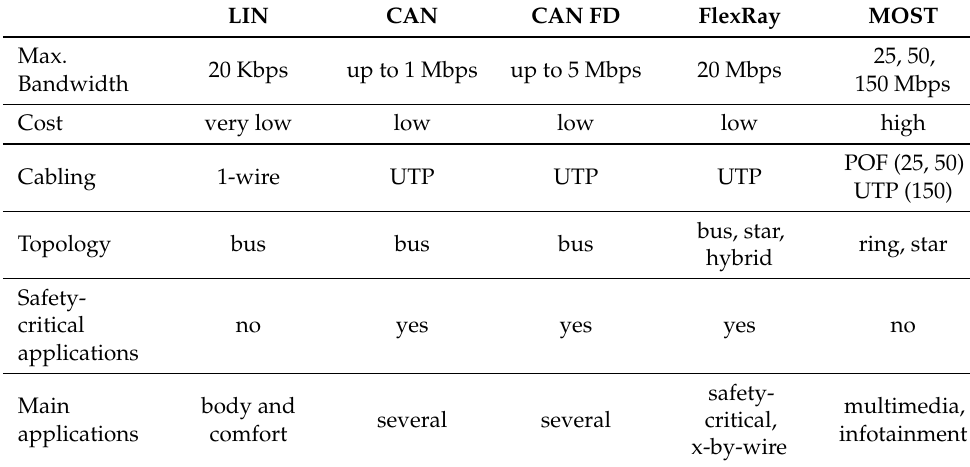
Table 2. Current in-car networking